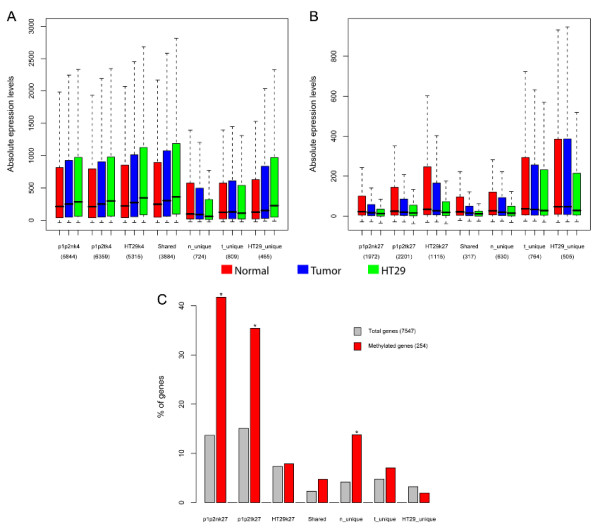
Hypersilencing of some of the H3K27me3 target genes may involve loss of the histone mark and DNA hypermethylation. In (A,B) the different gene groups presented in the bottom part of the figure correspond to all genes marked by H3K4me3 (A) or H3K27me3 (B) in both patients normal (p1p2n) or tumor samples (p1p2t) and in HT29 cell line. The Shared category included all those genes shared between normal, tumor and HT29 gene groups, either for H3K4me3 (A) or H3K27me3 (B). Similarly, the unique groups include those genes that are only found in normal (n_unique), tumor (t_unique) or HT29 (HT29_unique), when comparing the normal, tumor and HT29 gene groups. For each of these groups of genes, the expression values for normal colon (red), tumor samples (blue) and HT29 cell line (green) are indicated by boxplots and were obtained as described in Figure 4 D-E. In (C), only genes where both DNA methylation and ChIP-chip data were available were considered (Total genes = 7547), which was mainly limited by the coverage of the arrays used in the DNA methylation study. Then, for the same gene groups as in Figure 5B, we calculated the percentage of genes in each group represented with respect to the total of genes (grey) or those genes hypermethylated in CRC (red) as determined in Keshet el al [48]. Using a hypergeometric test we calculated if genes in the different gene groups were significantly over-represented (*, p.value < 0.01) among DNA hypermethylated genes compared to all genes.